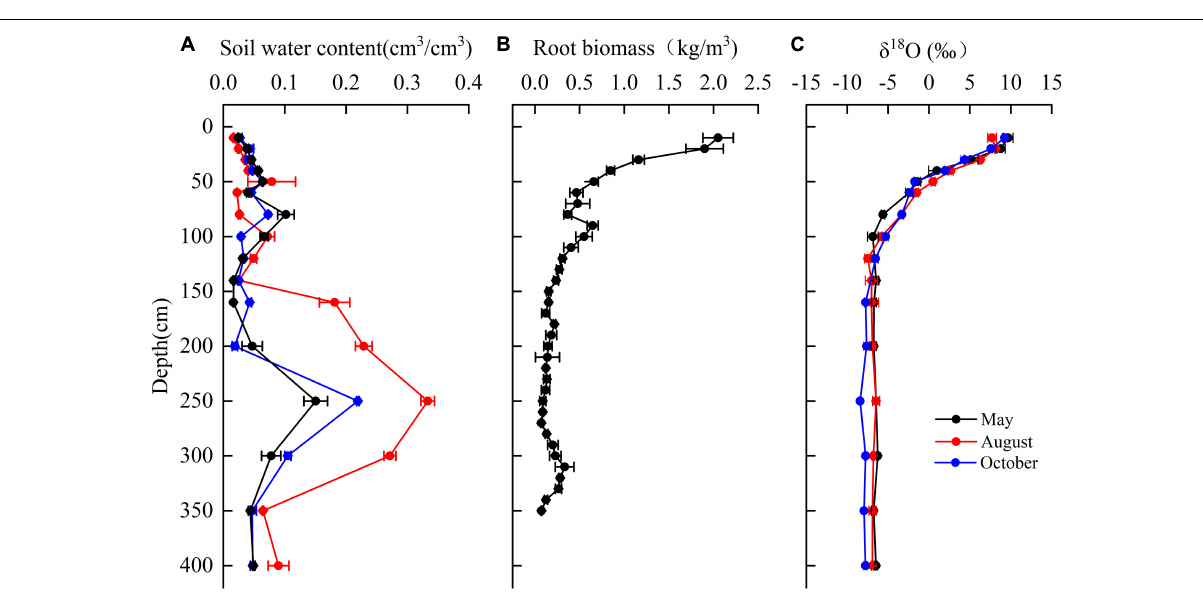
FIGURE 7 | The variation of (A) soil water content, (B) fine root biomass of T . ramosissima (0–350 cm), and (C) δ 18 O in the vertical soil profile during the 2020 growing